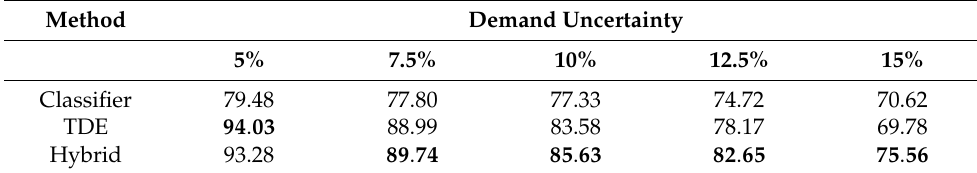
Figure 5. Comparing Location Accuracy. Table 1. Comparing Location Accuracy